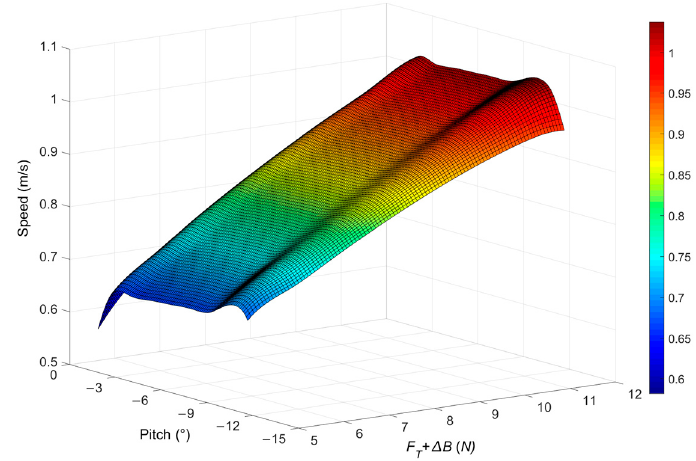
Figure 9. Speed simulation results of turbulence AUV.